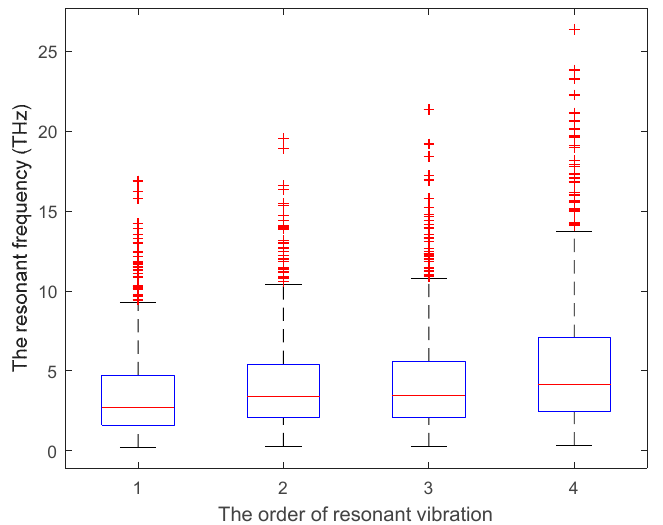
Figure 6. The statistic results of resonant frequency in the finite plane element model of graphene.